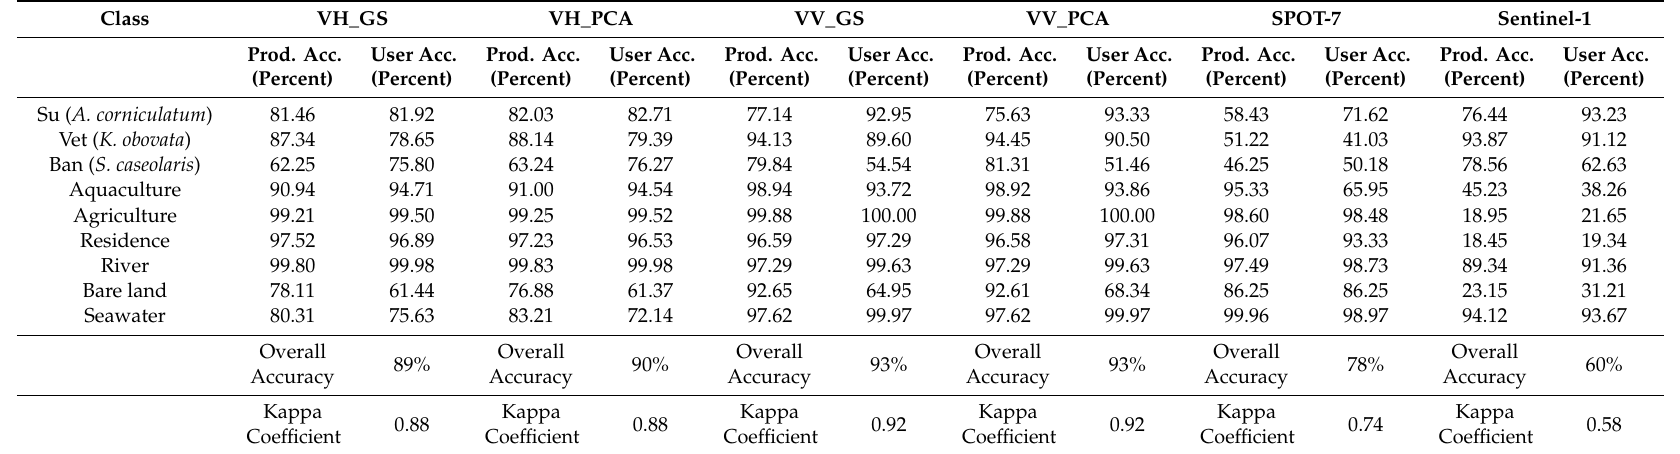
Table 4. Accuracy indexes calculated from confusion matrices for mangrove species classification assessment using SVM classifier, Prod. Acc. and User. Acc. are short forms of producer and user accuracy; VH_GS, VH_PCA, VV_GS, and VV_PCA are combinations of fused images of SPOT-7 and Sentinel-1 polarization data (VH or VV) and the image fusion methods (GS or